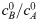
Experiments: Test of reciprocal relationships from initial conditions of cathodic and anodic mass transfer limited pre-polarizations for system where the bulk concentration ratio cB0/cA0 = 0.5.A) Relaxation of concentrations from initial condition corresponding to anodic pre-polarizatin (V = 100mV) at equilibrium potential (OCP = -162mV) B) Relaxation of concentrations from initial condition corresponding to cathodic pre-polarization (V = -500mV) at equilibrium potential (OCP = -162mV) C) disk currents from both anodic (bold) and cathodic (solid) initial conditions and their scaled sum iC/2 + iA (dashed line) D) ratio of concentrations cB(t)/cA(t) with a dashed line representing the bulk ratio cB0/cA0 = 0.5.